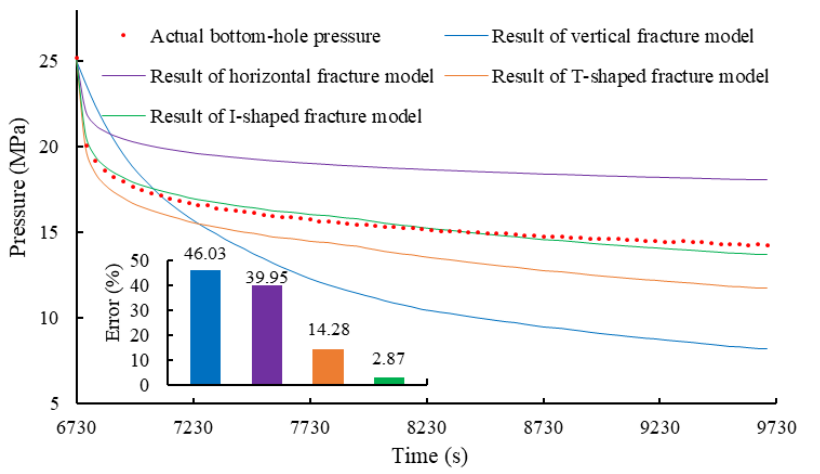
Figure 7. Comparison of bottom-hole pressure calculated by different models at the phase of pressure fall-off. Energies 2022 , 15 , x FOR PEER REVIEW 17 of 22